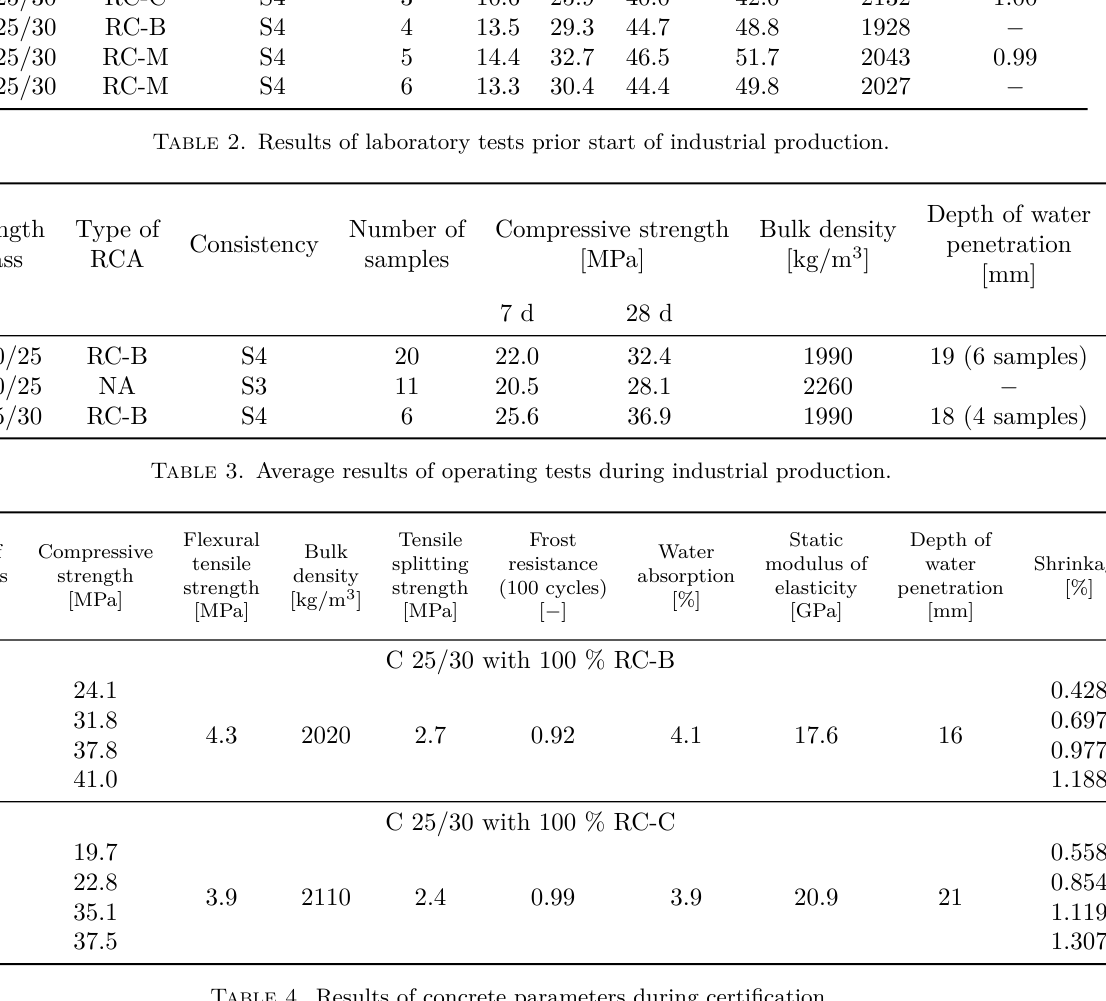
Table 4. Results of concrete parameters during